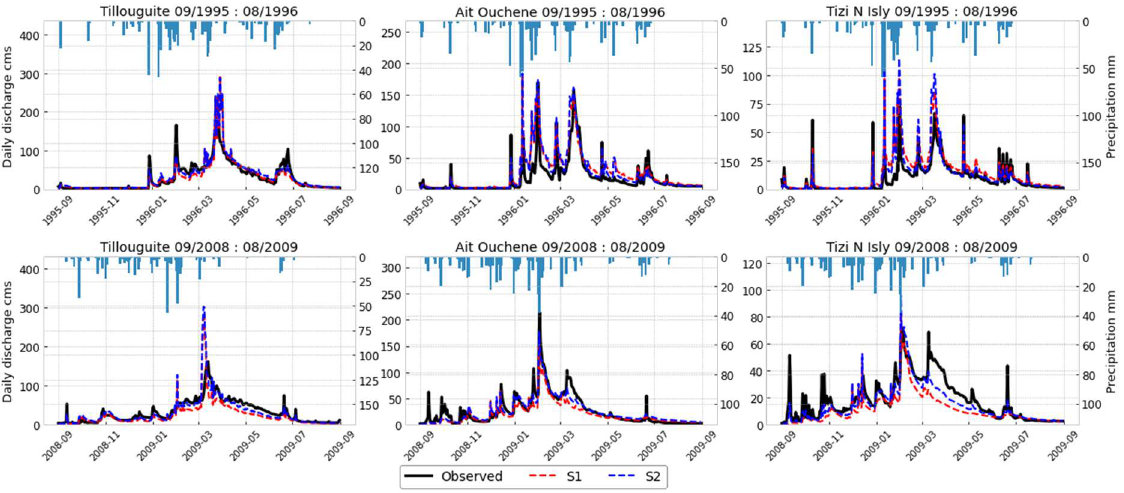
Figure A2. Hydrographs of simulated against observed daily streamflow for the years 1995–96 and 2008–09.